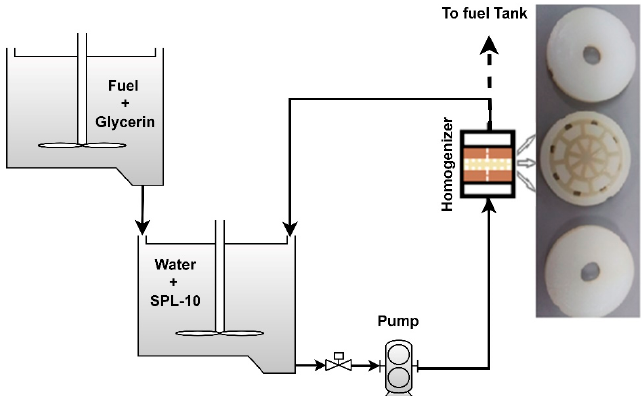
Figure 5. The instantaneous emulsion system before injection. Table 1. Experimental conditions in